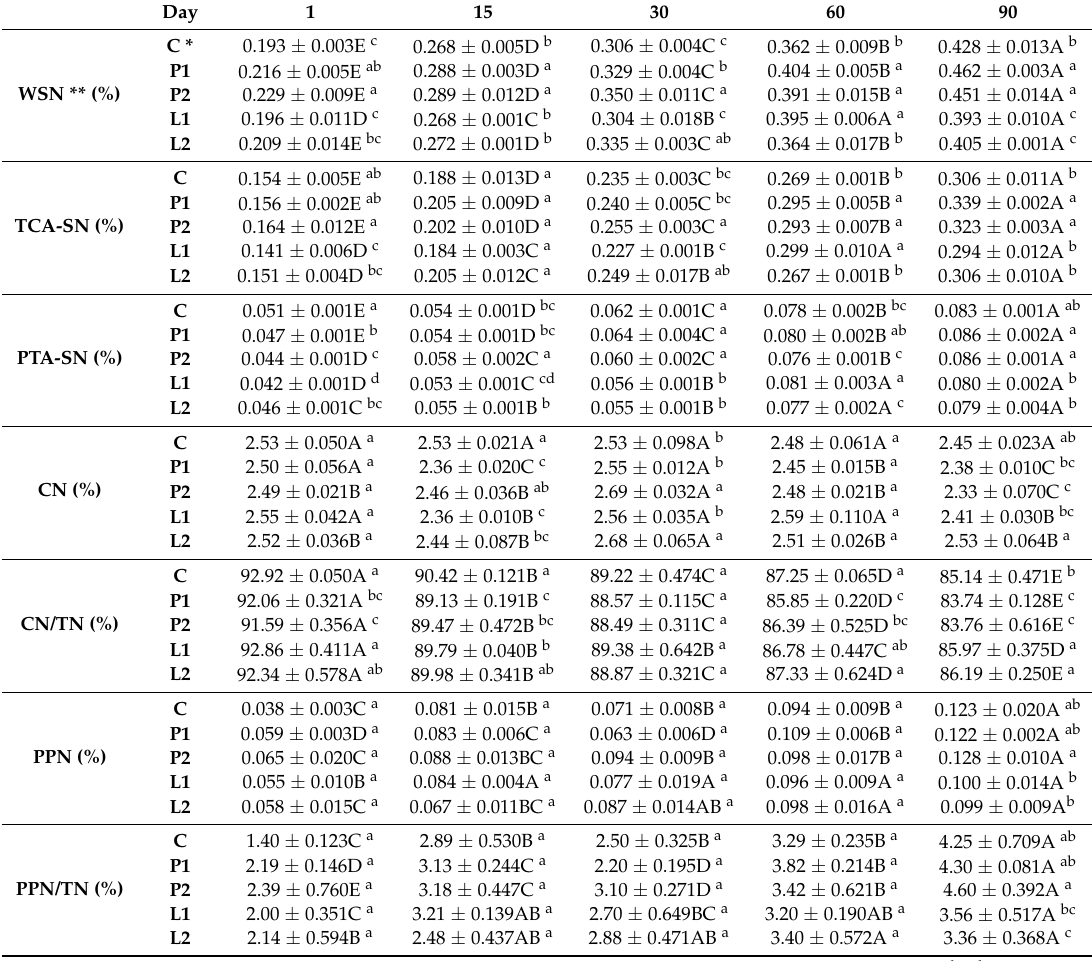
Table 4. Nitrogen fractions of experimental White cheeses during ripening ( n =